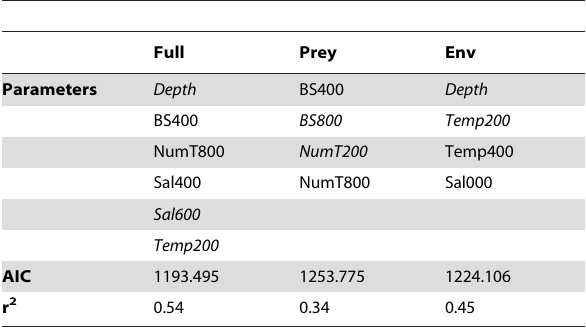
Table 2. Comparison of generalized linear model covariates for prey, oceanography, and prey-oceanography